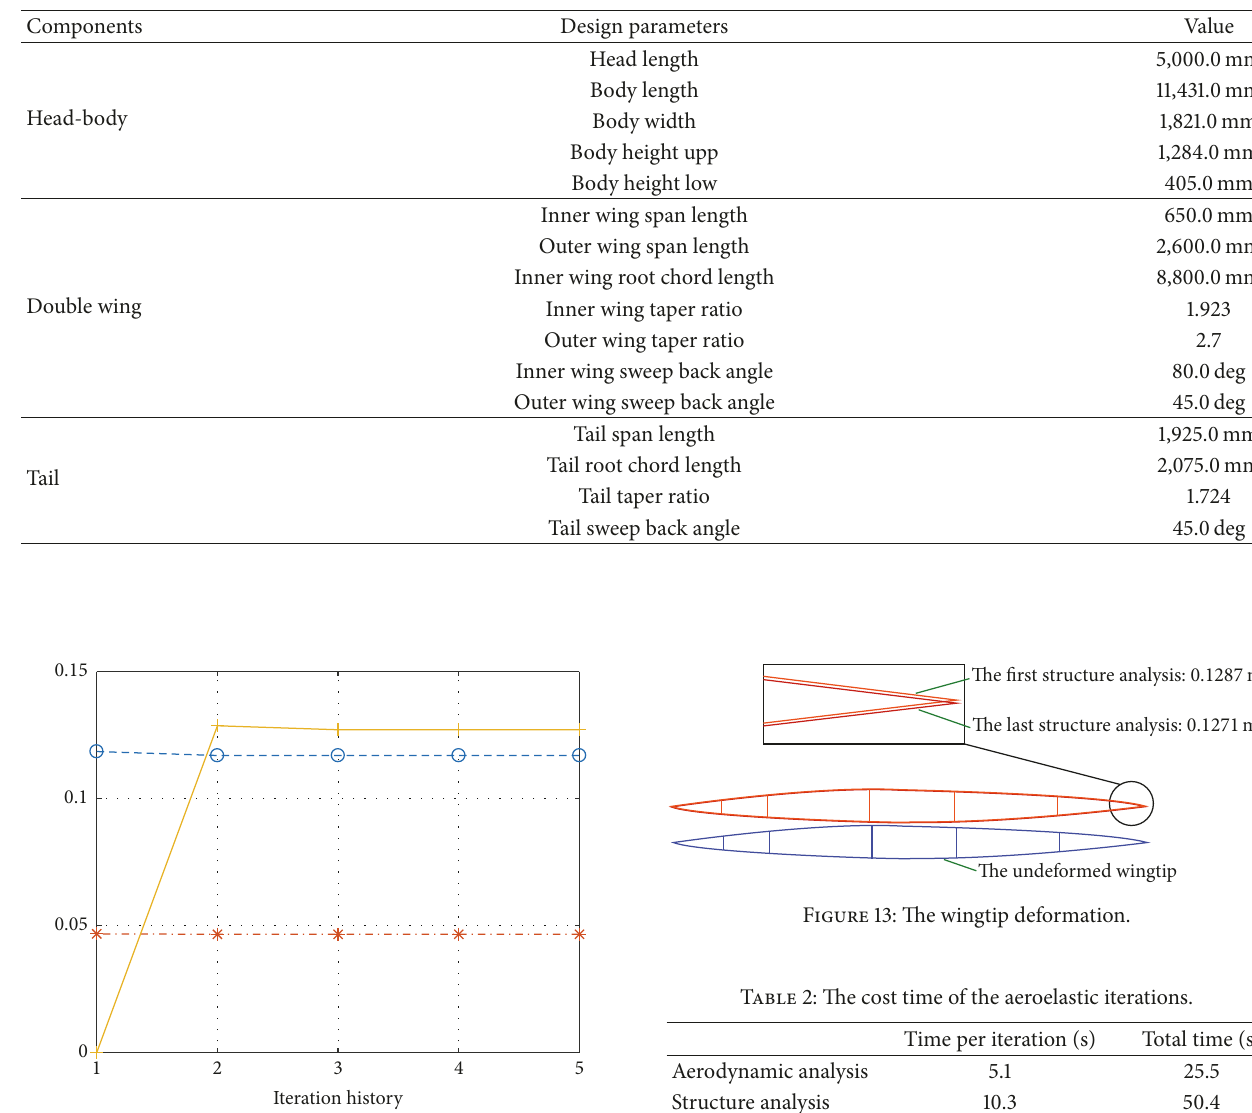
Table 1: Main parameters of the RLV.